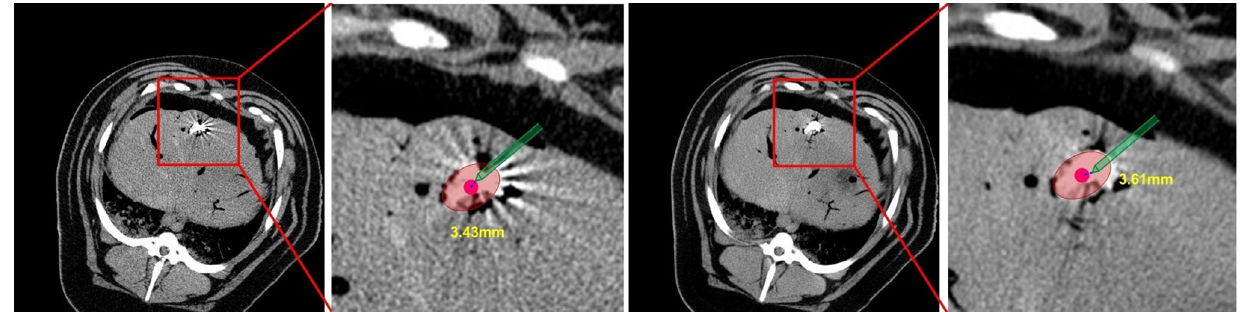
Fig. 9 Results of our mixed reality-based needle insertion